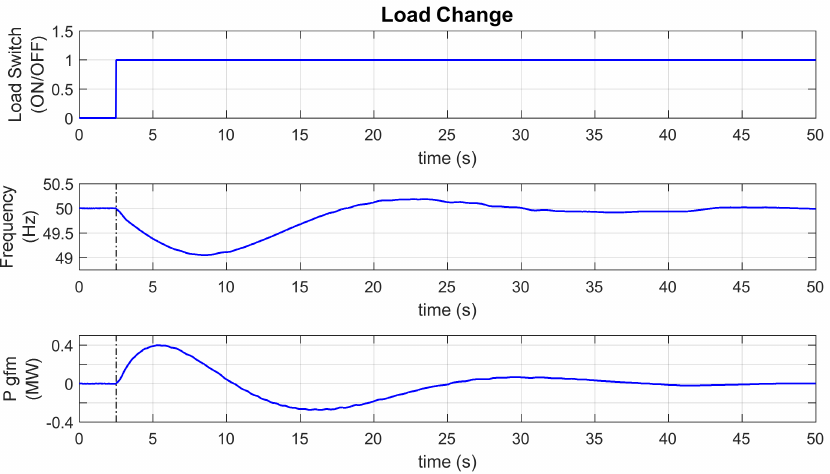
Figure 16. Power contribution by the converter at load change.